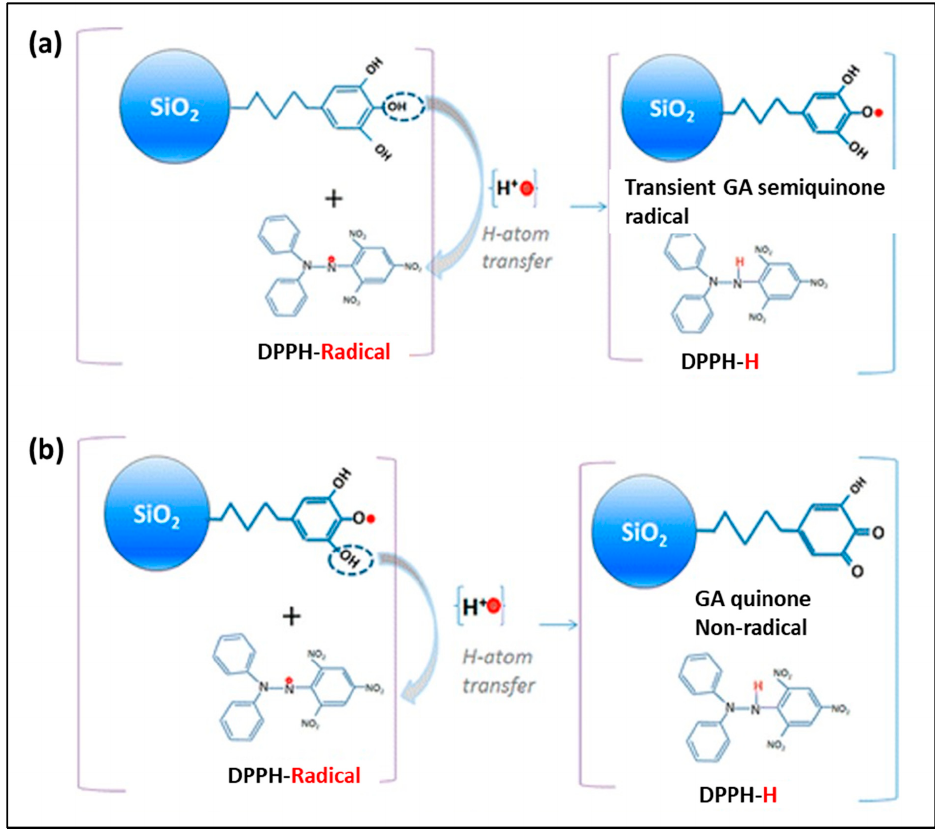
Figure 1. ( a ) Scavenging of one DPPH radical by SiO 2 -GA nanoparticles via HAT (H-atom transfer) reaction from the GA (Gallic acid) molecule forming a transient GA radical. ( b ) Scavenging of a second DPPH radical by SiO 2 -GA nanoparticles via HAT from the GA semiquinone forming a nonradical GA quinone. The figure was adapted from ref. [30], with permission from © 2012 American Chemical